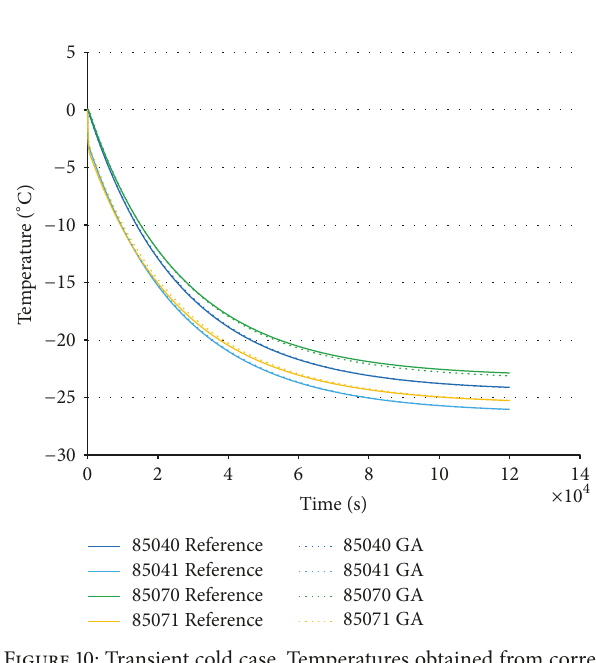
Figure 8: Transient hot case. Temperatures obtained from correla- tions with GA.